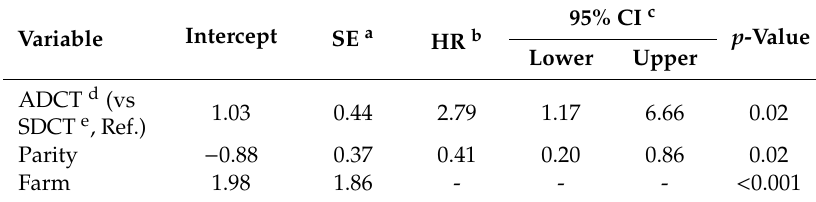
Table 8. Logistic regression for drying o ff protocols e ff ect on clinical mastitis risk during the first 60 days